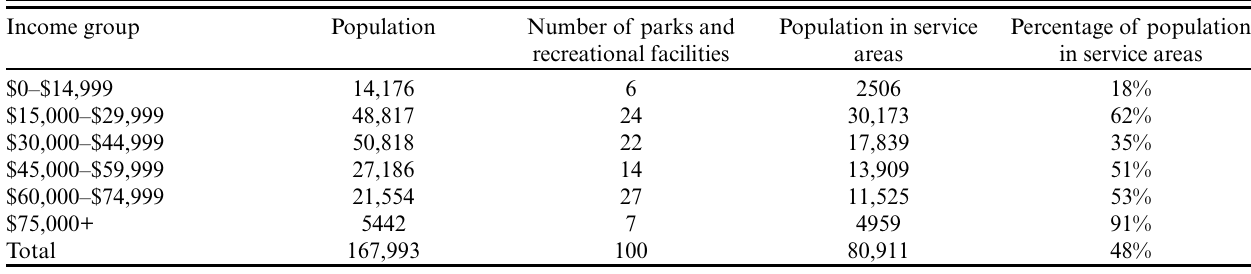
Table 1. Accessibility to urban parks by income